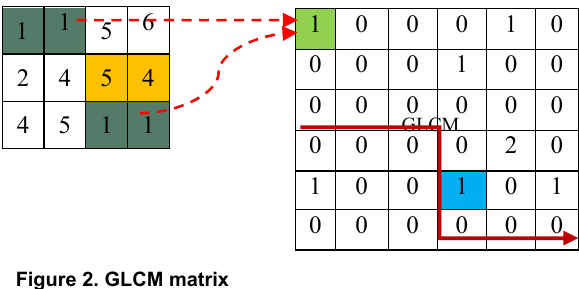
Figure 2. GLCM matrix